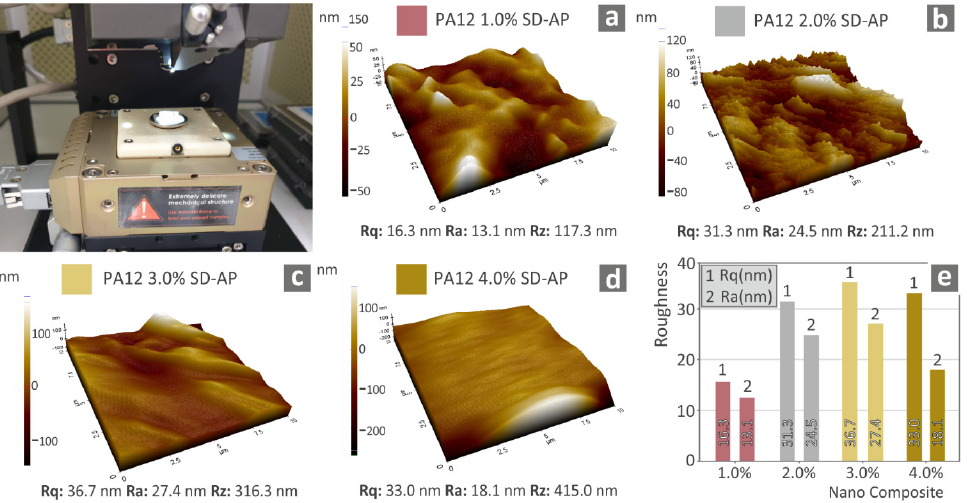
Figure 11. Atomic force microscopy surface roughness measurements on the side surface of the fil- aments of the materials prepared in this work: ( a ) 1 wt. %; ( b ) 2 wt. %; ( c ) 3 wt. %; ( d ) 4 wt. %; and ( e ) surface roughness measurements for the cases studied. ( e ) surface roughness measurements for the cases